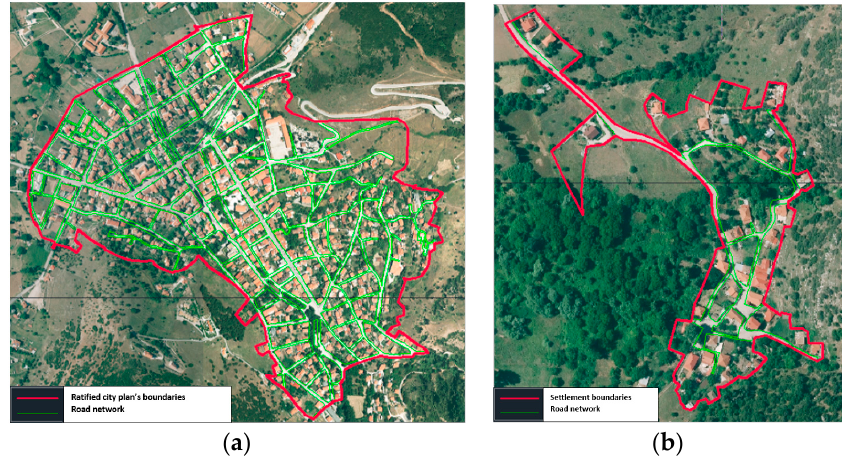
Figure 6. ( a ) Digitization of ratified city plan’s road network on orthophoto. ( b ) Digitization of the road network of an unplanned settlement using photo-interpretation tools. Source: [35].